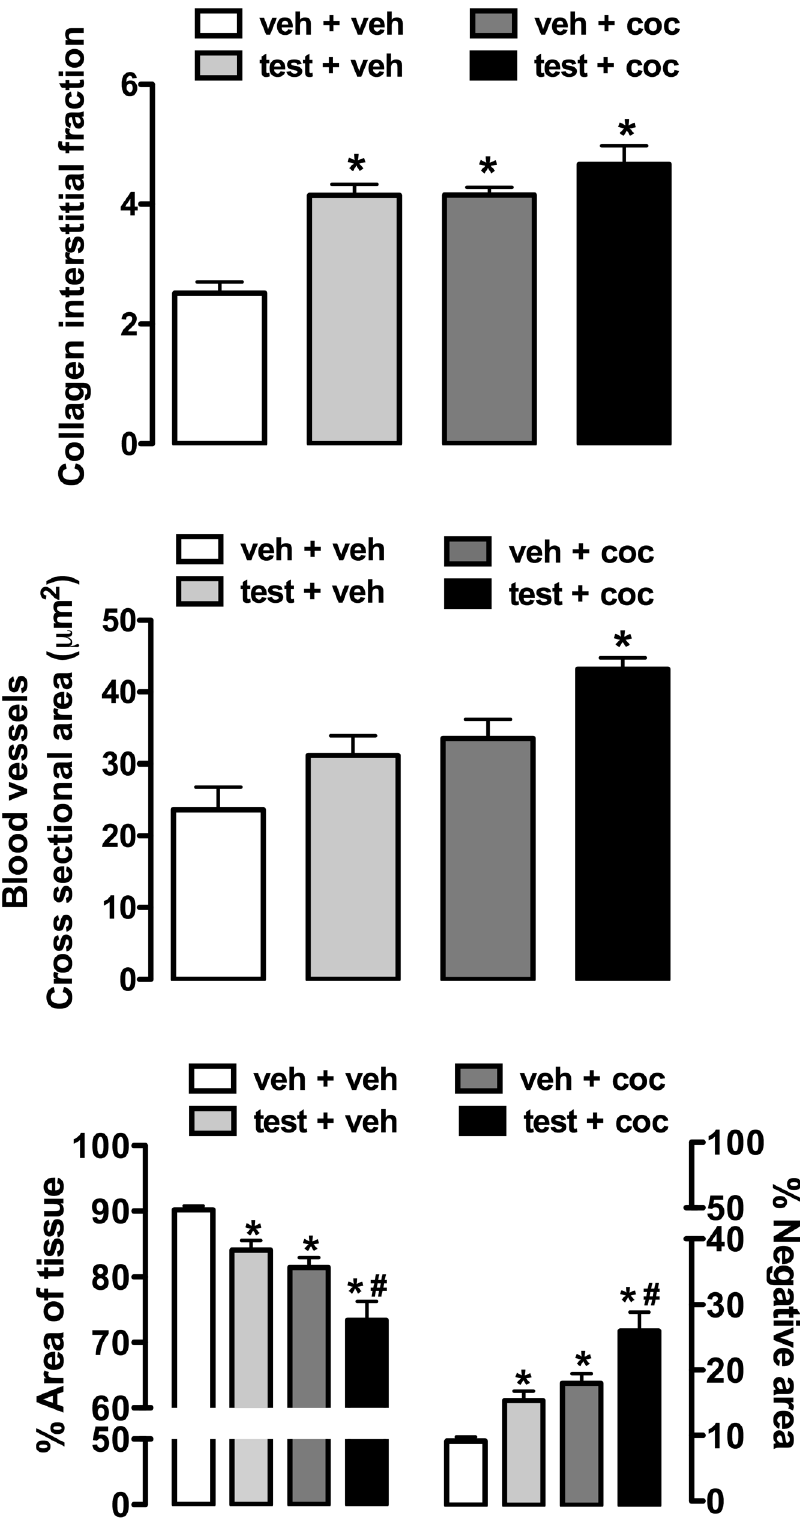
Figure 6. Morphometric measurements obtained in histological sections of left ventricle from adolescent rats subjected to treatment for 10 consecutive days with testosterone and cocaine alone and in combination. Collagen interstitial fraction (%) (top), cross sectional area of blood vessels (middle), and cardiomyocytes (area of tissue) and negative area (%) (bottom).The bars represent the mean 6 SEM. veh – vehicle, test - testosterone and coc - cocaine. * P , 0.05 vs veh + veh group, # P , 0.05 vs test + veh and/or veh + coc groups; one-way ANOVA followed by Bonferroni’s post hoc test.